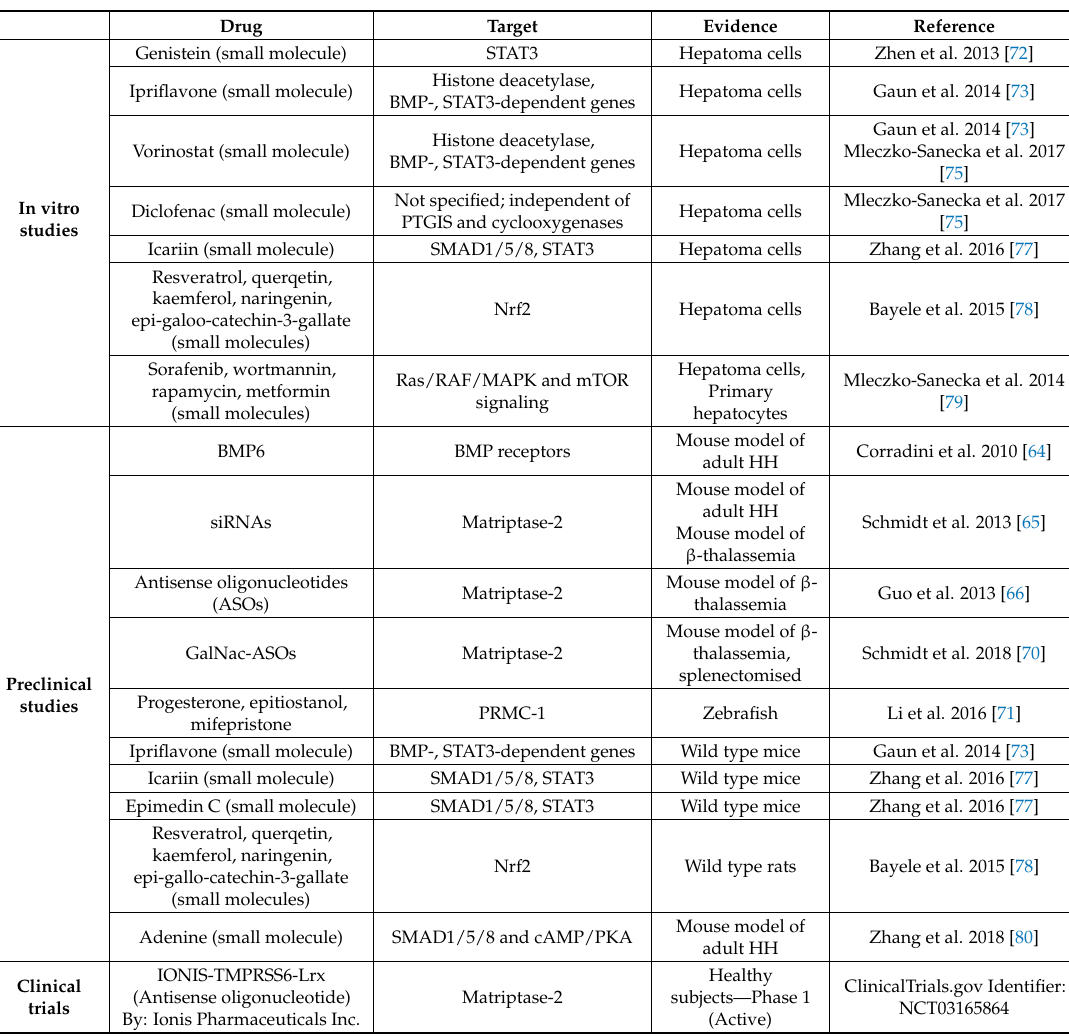
Inducers of hepcidin expression. Nrf2, nuclear factor (erythroid-derived 2)-like 2; PTGIS, prostaglandin I2 (prostacyclin) synthase; MAPK, mitogen-activated protein kinase; PRMC-1, progesterone receptor membrane component-1; PKA, protein kinase